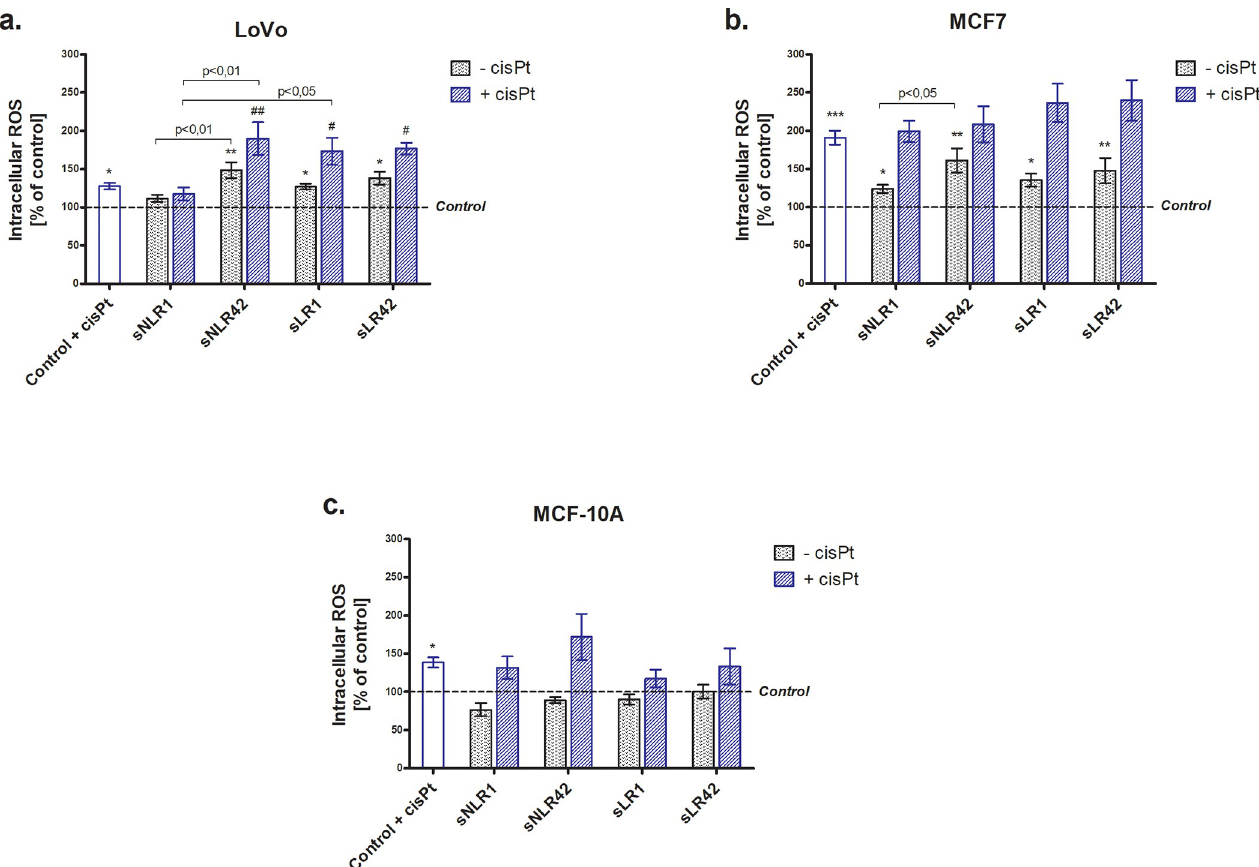
Fig 3. The intracellular ROS level in LoVo (panel a), MCF7 (panel b), and MCF-10A (panel c) after incubation (1 h at 37˚C) with the PRBC supernatants (5%) in the absence or presence of cisPt (panel a and b: 25 μ M; panel c: 40 μ M). All data is presented as a percentage of control (untreated cells—assumed as 100%). Error bars denote ± SD, n = 25 (5 independent experiments, each performed with supernatants of PRBCs derived from five donors); � /# p < 0.05; �� /## p < 0.01 compared to the appropriate control, ��� p < 0.001 vs. control (untreated cells).